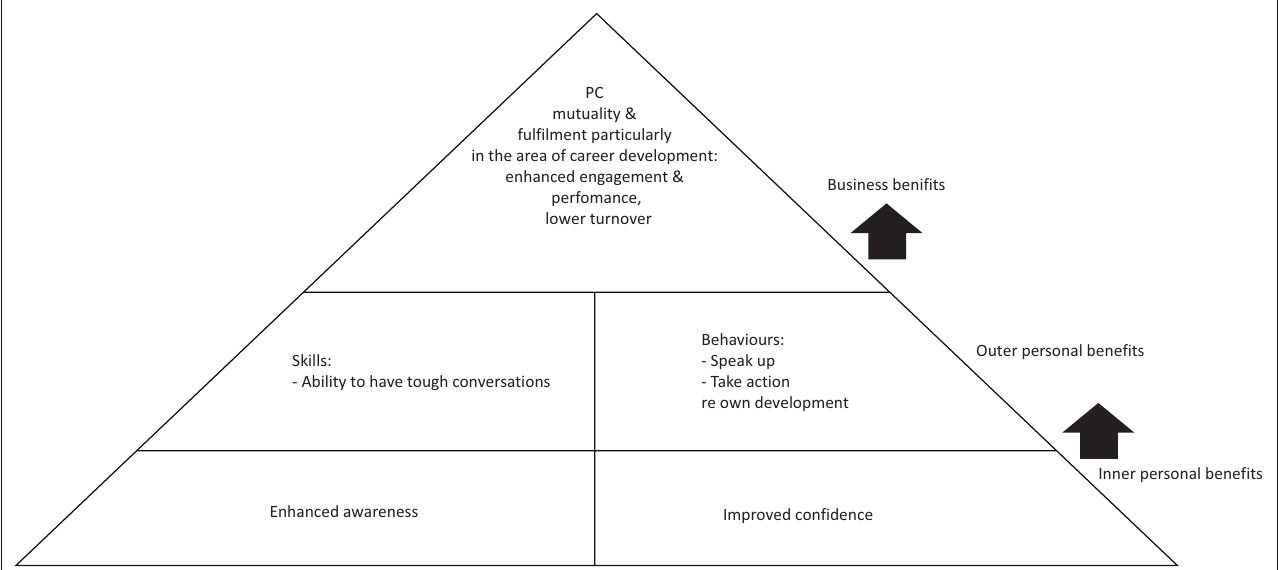
FIG URE 1: Coaching and psychological contract alignment